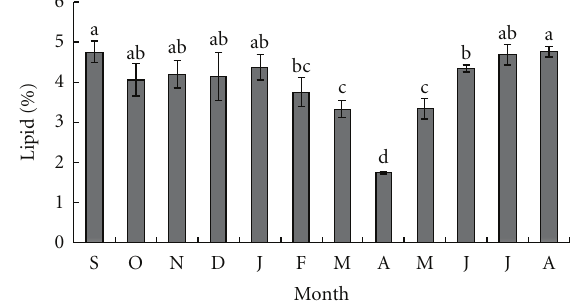
Figure 4: Monthly variation of lipid levels in sea urchin gonads. Columns with the same letter are not significantly di ff